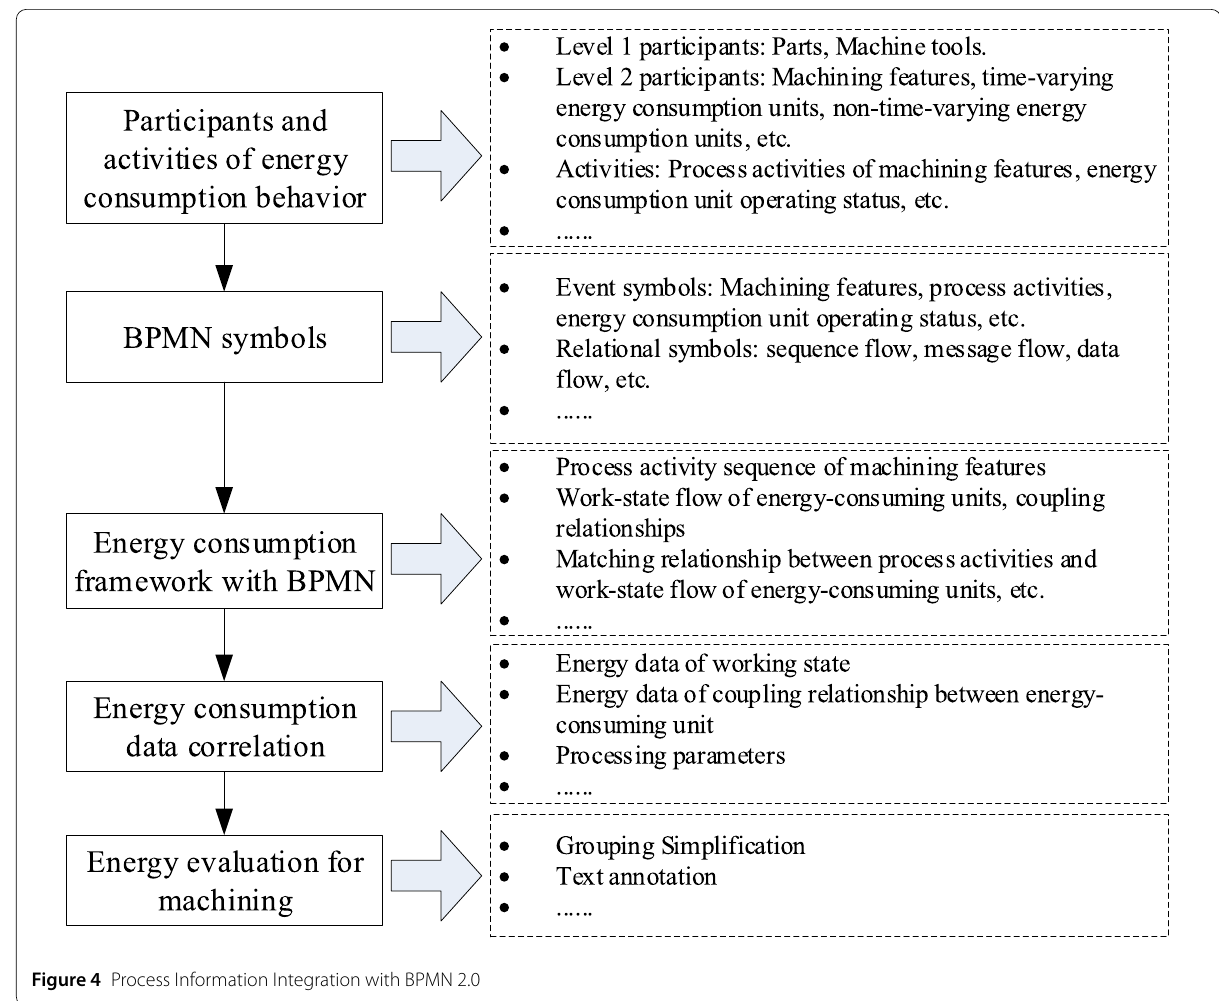
Figure 4 Process Information Integration with BPMN